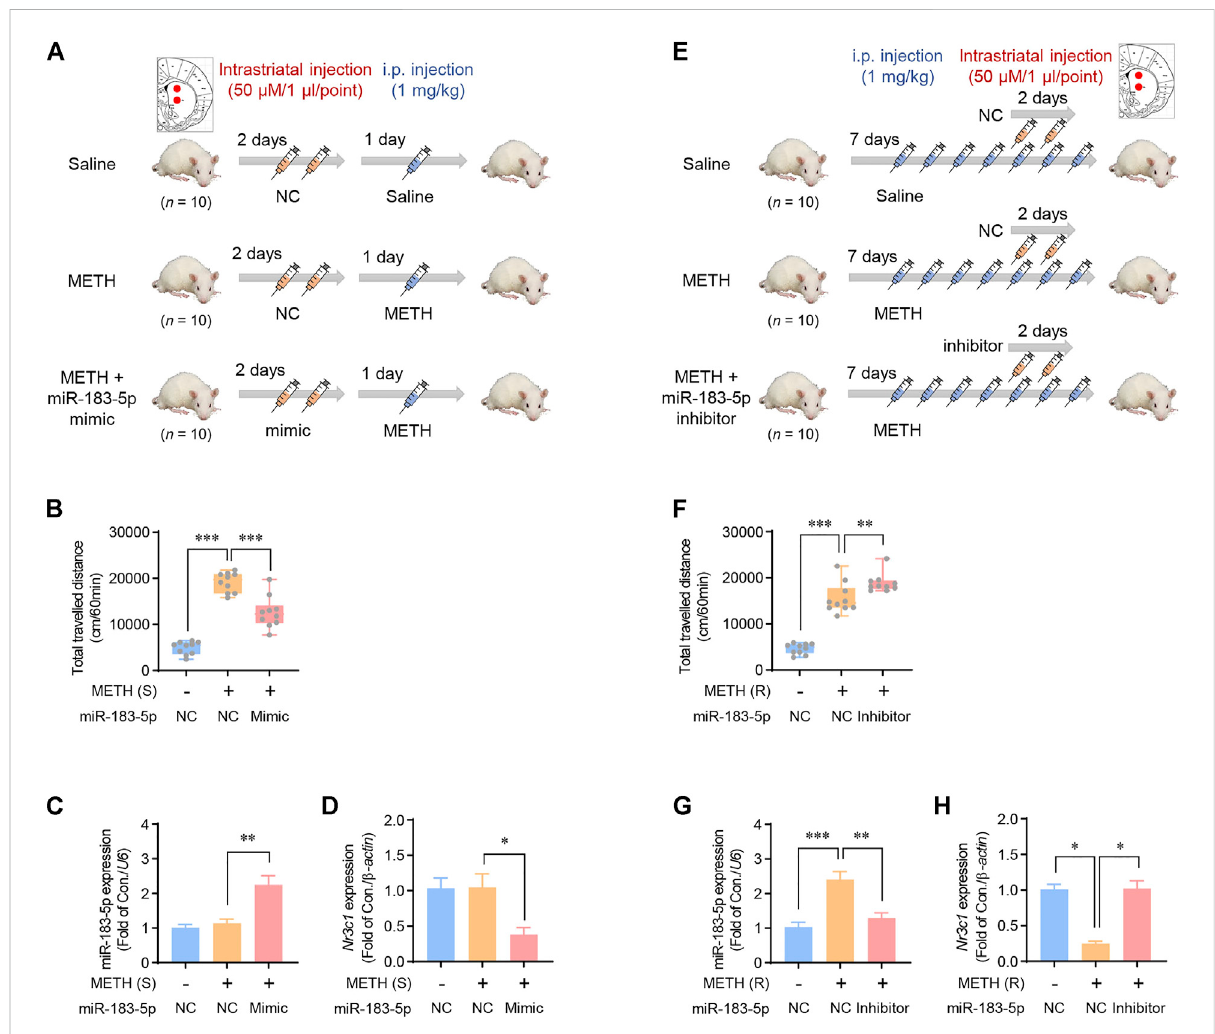
FIGURE 4 Effects of striatal miR-183-5p on METH-induced locomotor activity. (A) Flowchart showing an overview of a single METH injection. Rats were injected withvehicleormiR-183-5p mimic twicebefore METHinjection. (B) The locomotoractivitiesofratswererecorded1 hafter METHinjection. Statistical analysis was performed using the one-way ANOVA. Error bars represent mean ± SEM ( n = 10). ** p < 0.01, *** p < 0.001. (C,D) MiR-183-5p and Nr3c1 expressionlevelinthestriatumwasanalyzedandnormalizedto U6 and β -actin level.Dataarepresentedasthefoldchangerelativeto the control group. Statistical analyseswere performed using the one-way ANOVA. Error bars represent mean ± SEM ( n = 5).* p < 0.05, ** p < 0.01. (E) Flowchart showing an overview of repeated METH injections. Rats were injected with vehicle or miR-183-5p inhibitor on the 5th and 6th days following METH injections. (F) The locomotor activities of rats were recorded 1 h after METH injection. Statistical analyses were performed using the one-wayANOVA.Errorbarsrepresentmean±SEM( n =5).** p < 0.01,*** p < 0.001. (G,H) MiR-183-5pand Nr3c1 expressionlevelinthestriatumwas analyzed and normalized to U6 and β -actin level. Data are presented as the fold change relative to the control group. Statistical analyses were performed using the one-way ANOVA. Error bars represent mean ± SEM ( n = 5). * p < 0.05, ** p < 0.01, *** p <